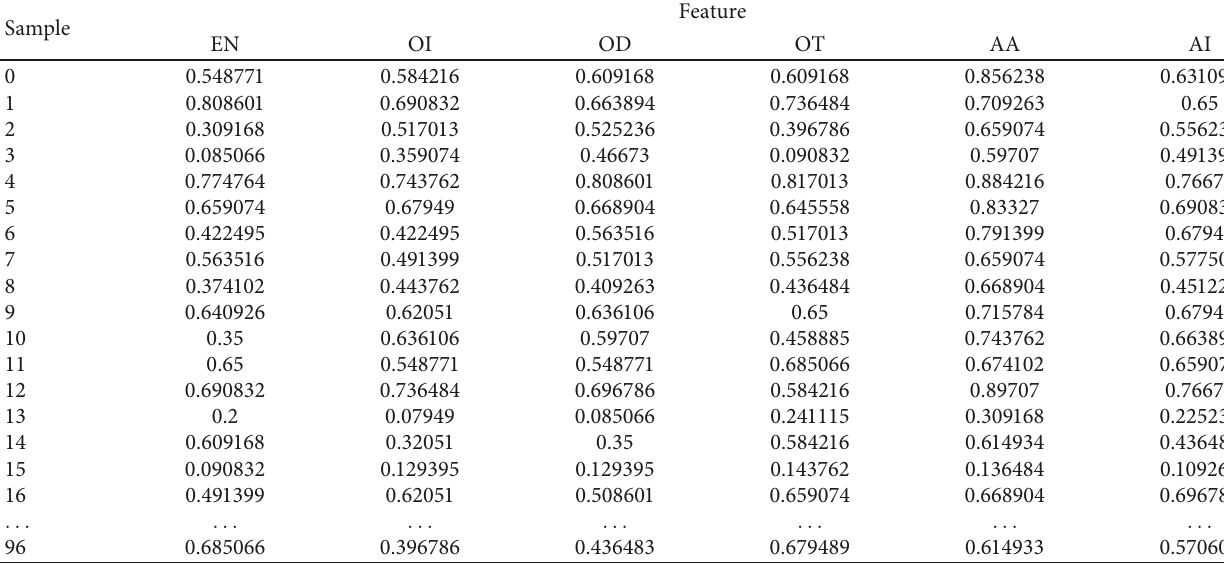
Table 6: Complexity degree matrix of samples.